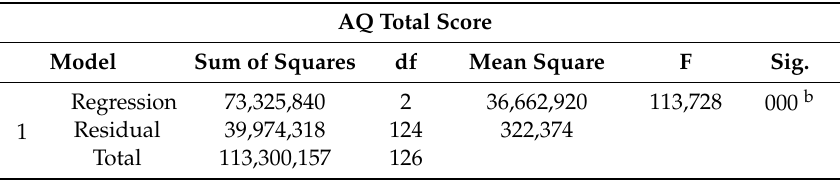
Table 2. Regression equation AQ gender and diagnosis.